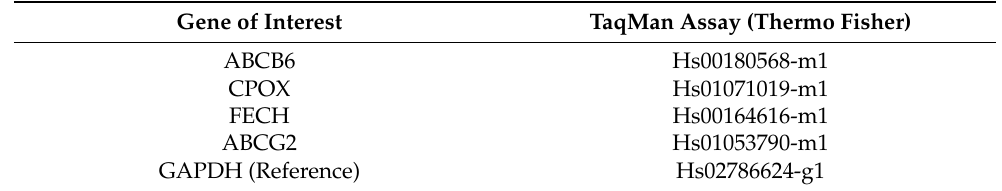
Table 2. Summary of the gene expression assays used for qPCR. Predesigned TaqMan Gene Expres- sion Assays (Thermo Scientific, Dreieich, Germany) were used to quantify ABCB6, ABCG2, CPOX and FECH mRNA expression in relation to the internal control (GAPDH).